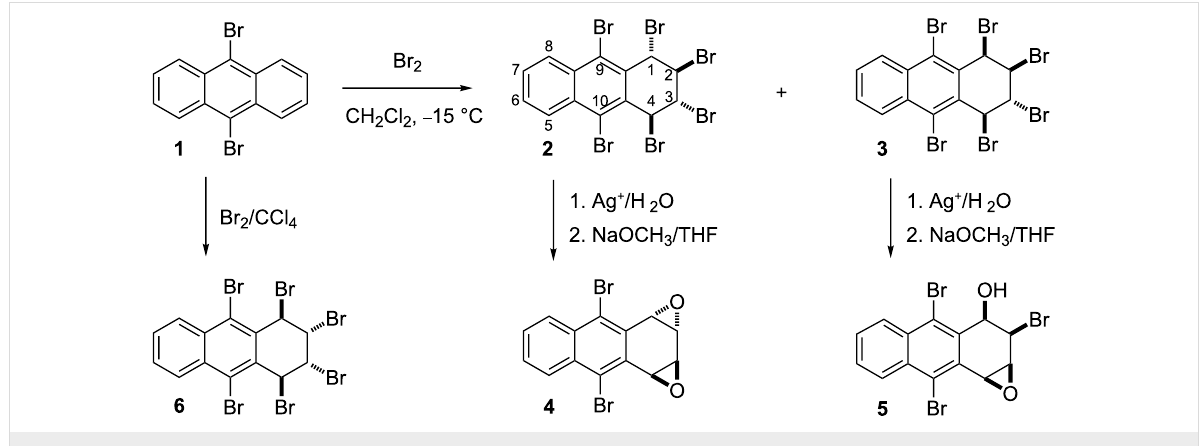
Scheme 1: Synthesis of anthracene oxides.